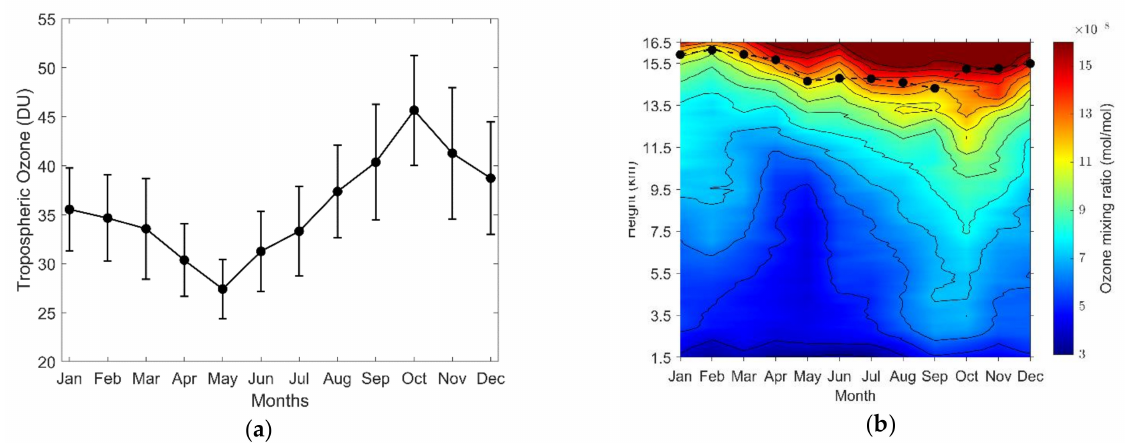
Figure 3. Tropospheric ozone data obtained from ozonesondes launched at Irene: ( a ) Monthly mean and standard deviation of the total tropospheric ozone column obtained from ozonesondes between 1998 and 2018; ( b ) Monthly mean ozone mixing ratio from 1.5 to 16.5 km above sea level and monthly mean lapse-rate tropopause obtained from ozonesondes between 1998 and 2018 (dashed black line).